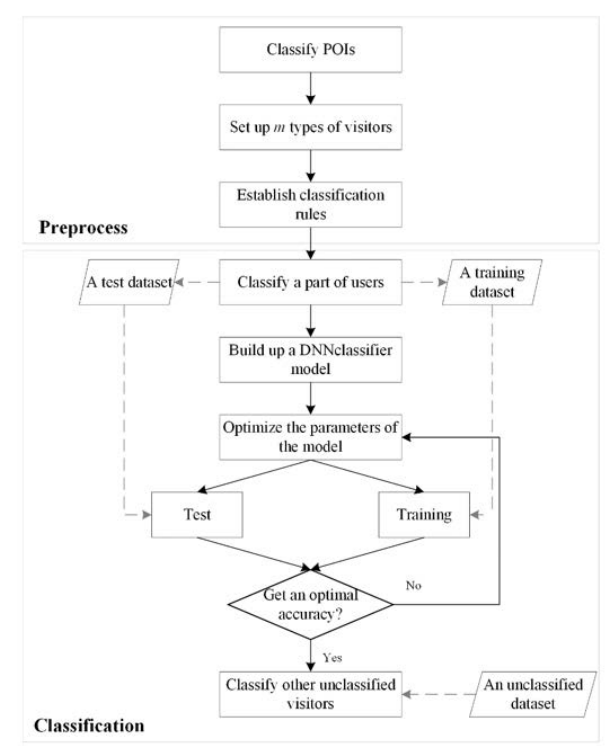
Figure 2. Workflow of user behaviour